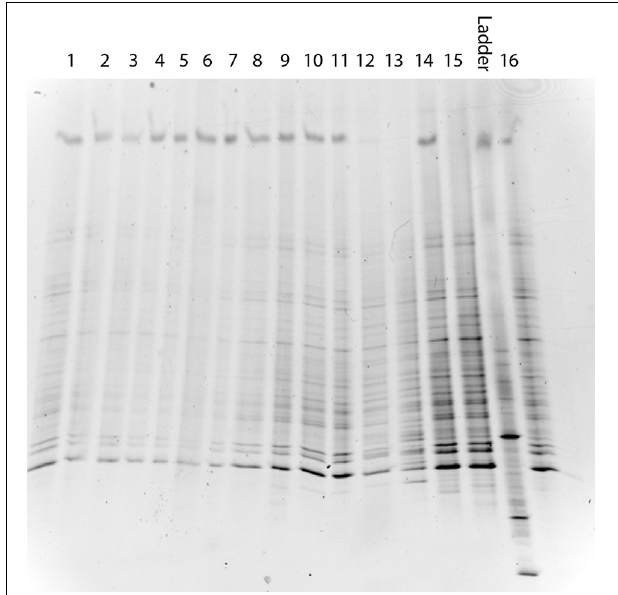
FIGURE 3 | Internal transcribed spacer 2-DGGE analysis of 16 samples belonging to genet PD100 from the volcanic pools at Isabela identified Symbiodinium ITS-2 sublcade C1d as the major symbiont in all samples. Second to last lane from the right is the size standard (mixture of clades D1, B1, and C1).